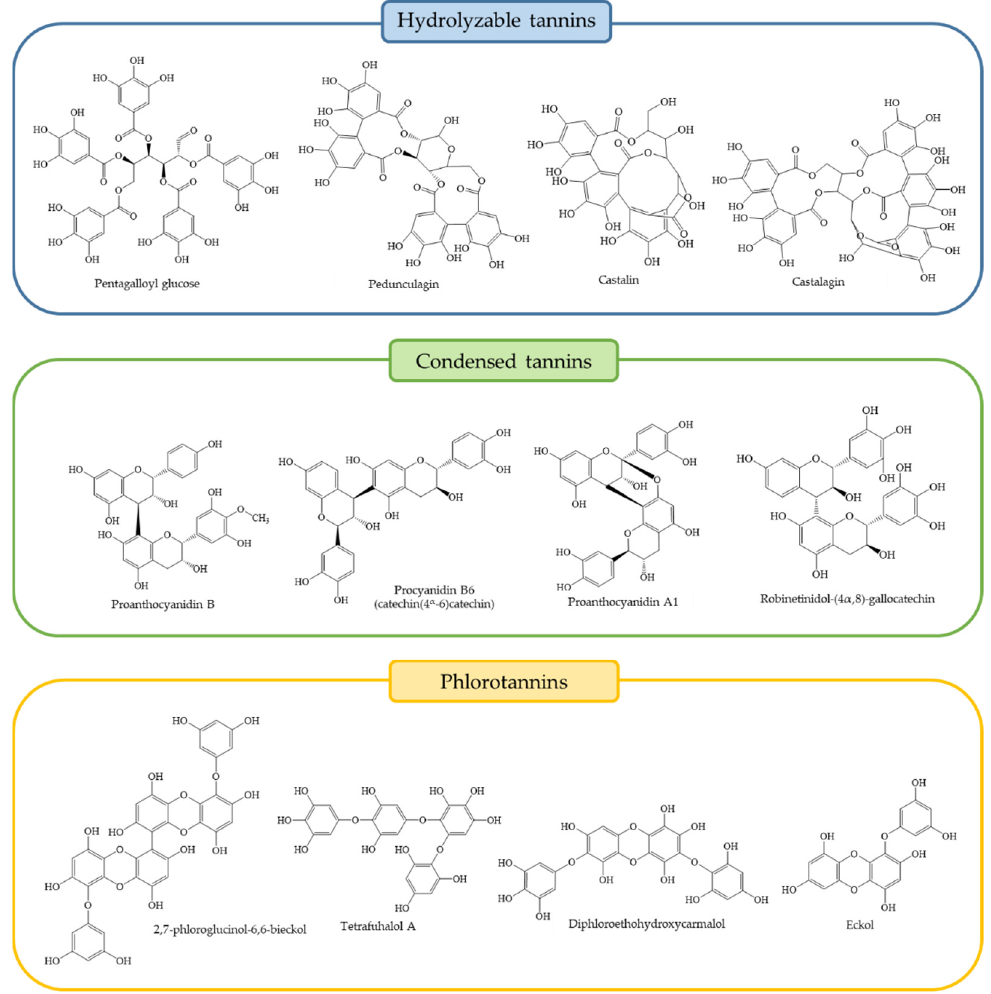
Figure 3. Chemical structure of main tannins present in the selected species.